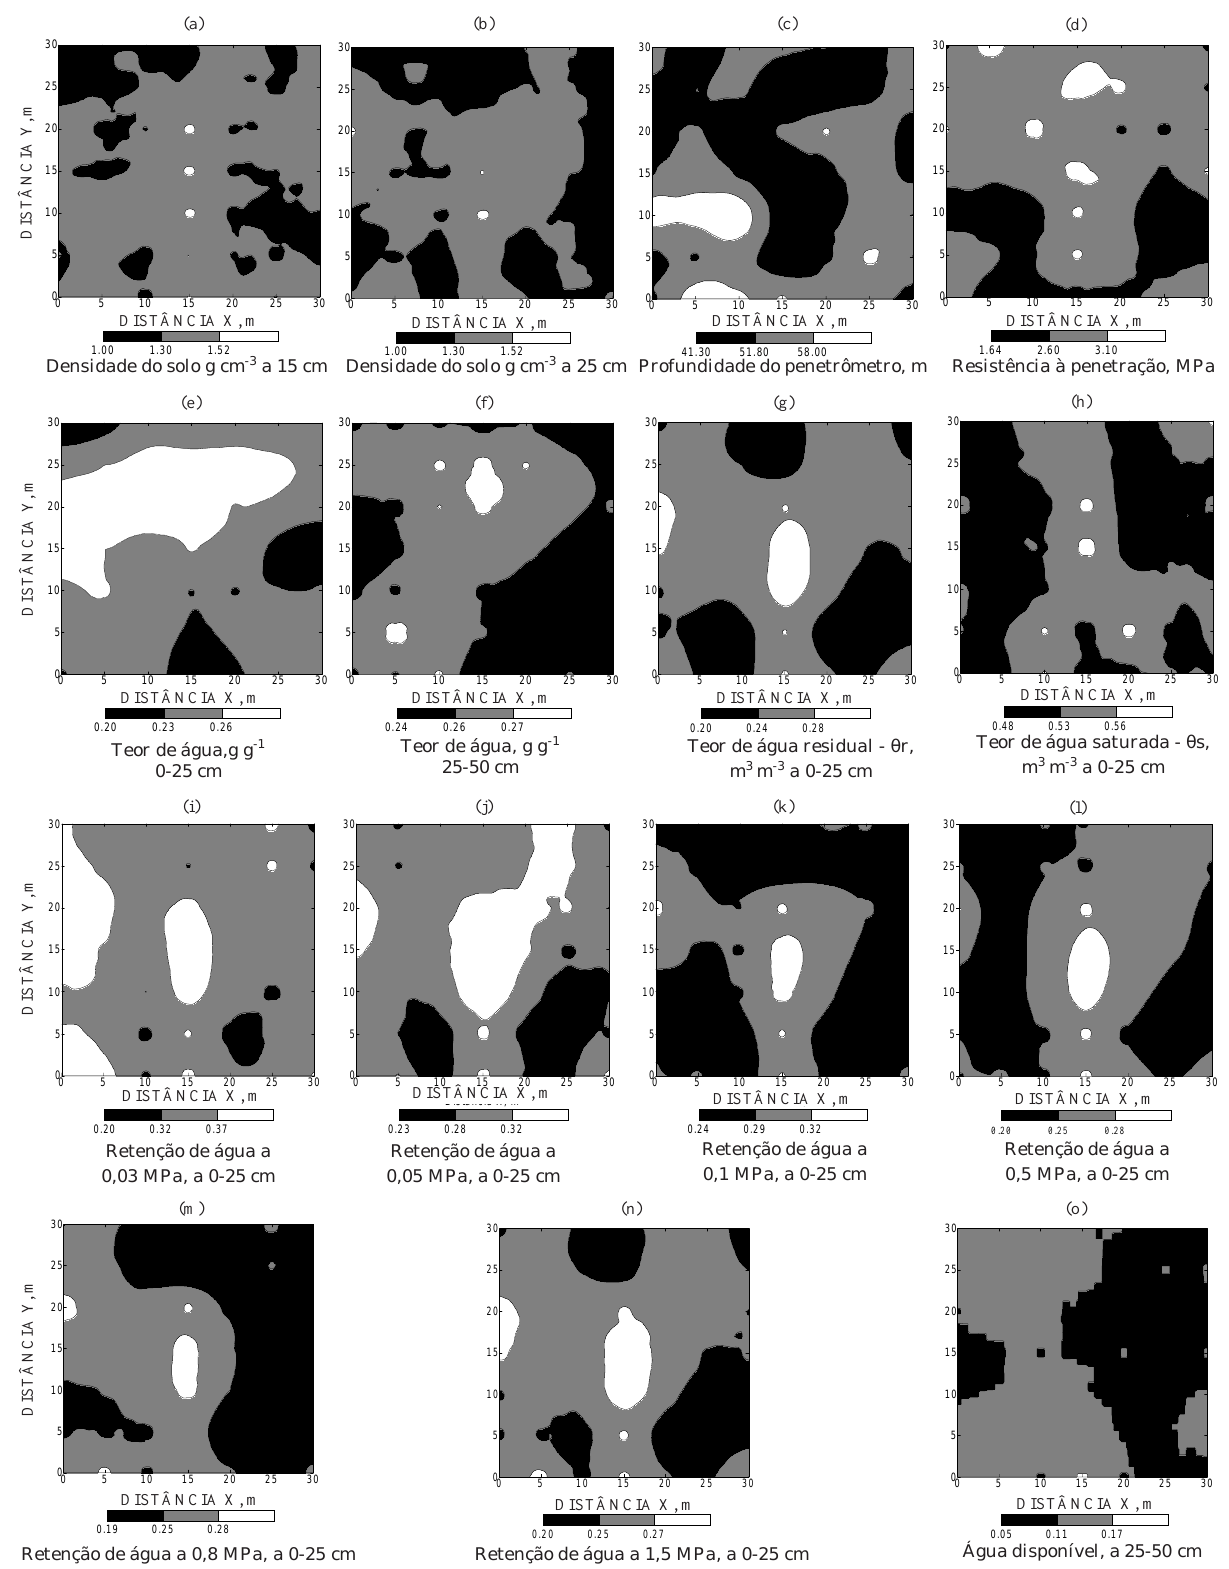
Retenção de água a 0,8 MPa, a 0-25 Figura 3. Mapas das variáveis estudadas, a diferentes profundidades, com valores estimados por krigagem.